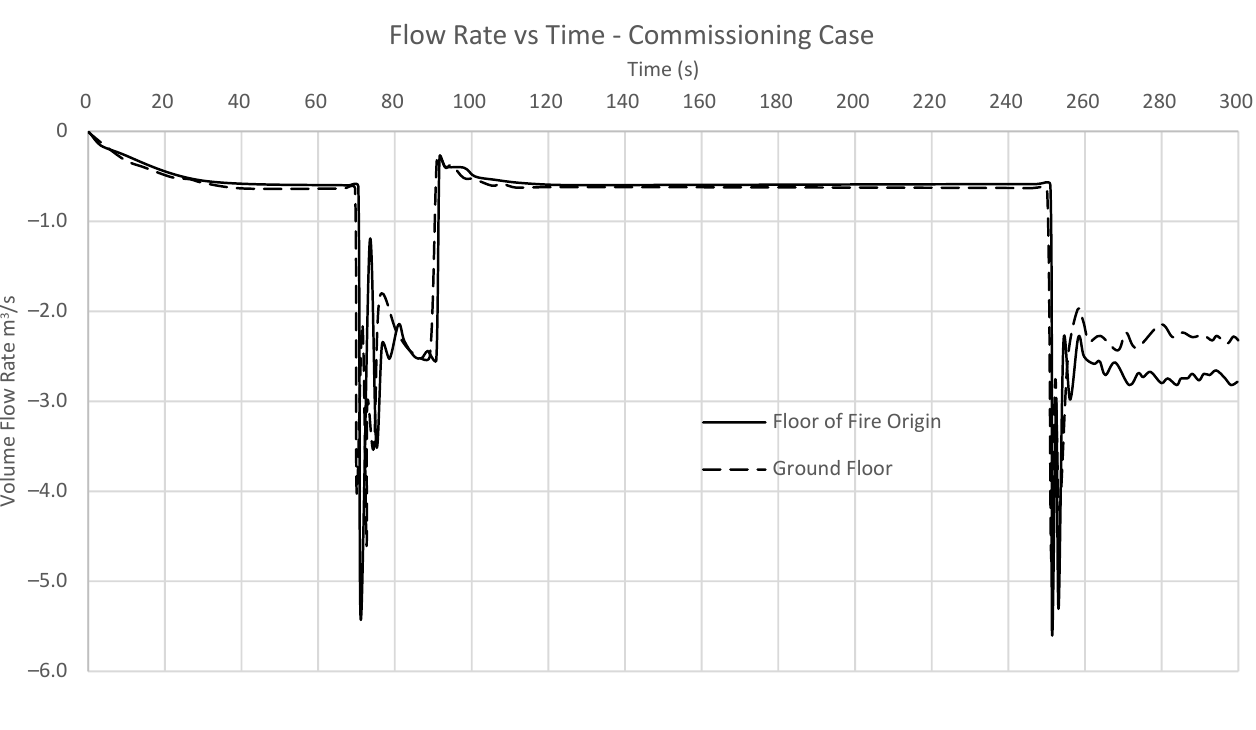
Figure 6. Volume flow throughout stairs of interest with 2 doors open simultaneously.